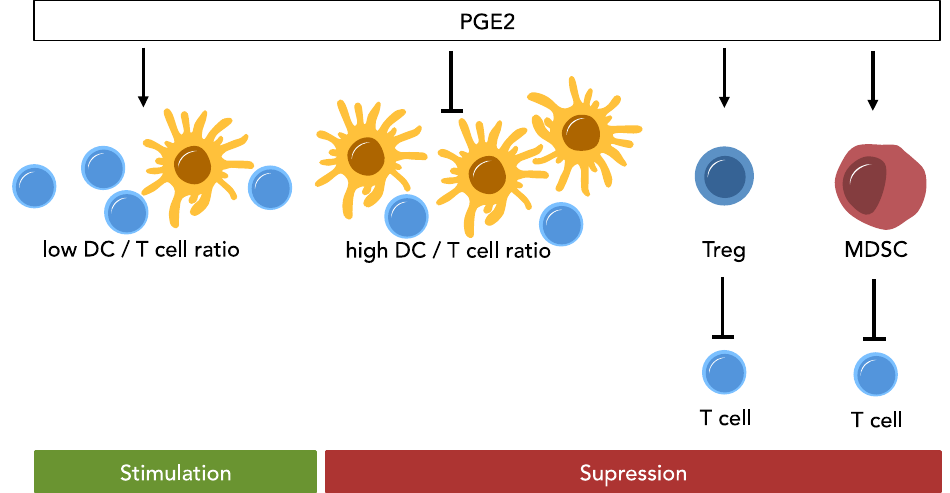
Figure 2. Effect of PGE2 on anti-cancer T cell activity. PGE2 has a differential impact on T cell activity, showing stimulatory effects at low DC/T cell ratios, but suppressive effects as DC numbers increase. PGE2 increases activation of Tregs and is involved in MDSC formation, which in turn hampers anti-cancer immunity. MDSC: myeloid derived suppressor cell; Treg: regulatory T cell; DC: dendritic cell.